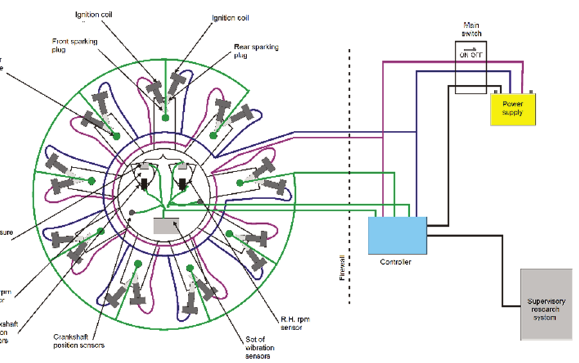
Fig. 2. Ignition system of ASz-62IR-16X engine